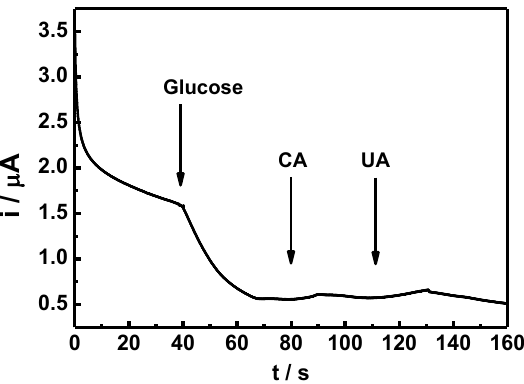
Figure 10. Amperometric response of the GO x /SnS/GCE electrode to 0.1 mM glucose, as well as 0.1 mM interferents of uric acid (UA) and citric acid (CA).